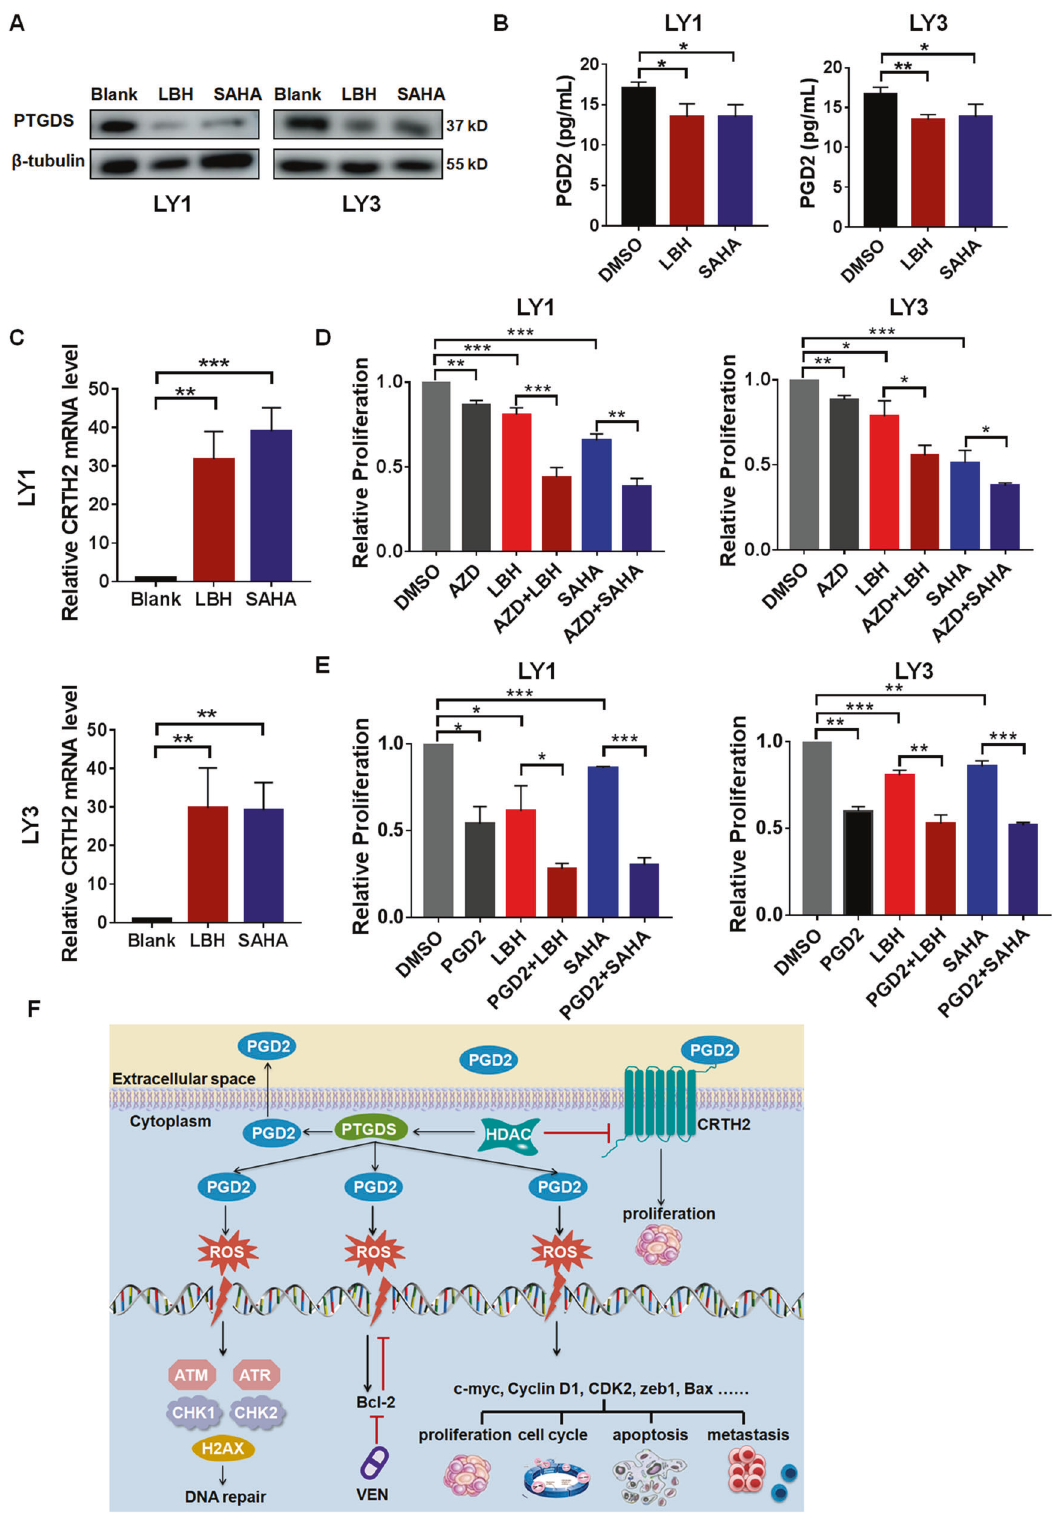
Fig. 5 HDAC inhibitors regulated the expression and effects of PGD2 and CRTH2 in DLBCL cells. A , B The expression level of PTGDS and the production of PGD2 were decreased by vorinostat (SAHA) and panobinostat (LBH589) in DLBCL cells. C SAHA and LBH589 increased the expression of CRTH2 in DLBCL cells. The expression of CRTH2 in cells without drug treatment was adjusted to 1. D , E The treatment of AZD1981 (AZD) and high-concentration PGD2 enhanced the cytotoxicity of HDAC inhibitors in LY1 and LY3 cells. F Mechanism diagram summarized that PGD2-CRTH2 enhanced tumor progression and high-concentration PGD2 exhibited potent anti-tumor activities through ROS-dependent DNA damage in DLBCL. Cells were treated with drugs for 48 h. Data are shown as the mean ± SD. * p < 0.05; ** p < 0.01; *** p < 0.001.